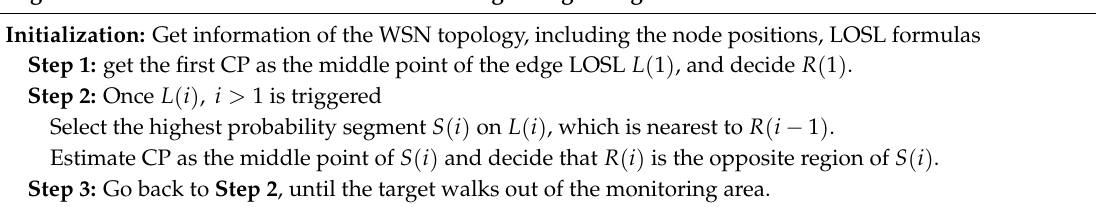
Algorithm 1. The CP Determination for Tracking a Single